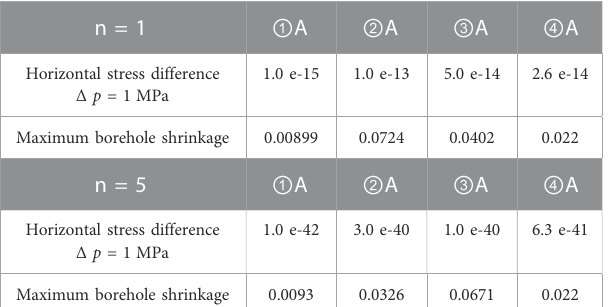
TABLE 2 The pre-coef fi cient A and the exponent n (Layer No. 2), in the case of n = 1 and